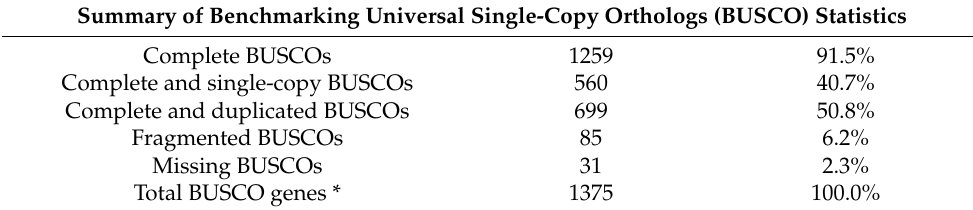
Table 2. Validation of the de novo transcriptome assembly of Imperata cylindrica .